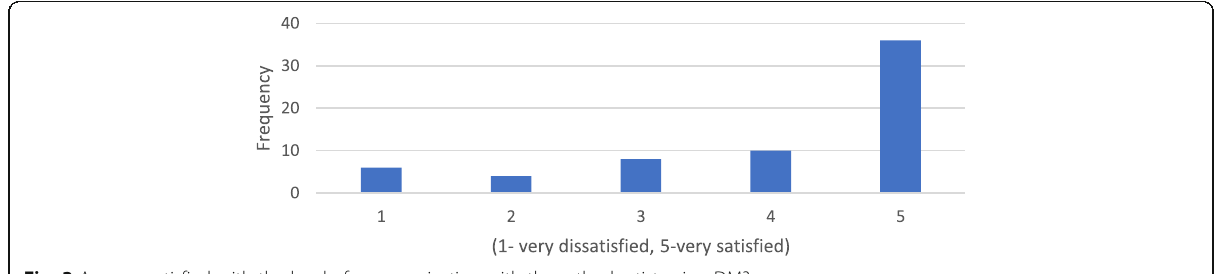
Fig. 3 Are you satisfied with the level of communication with the orthodontist using